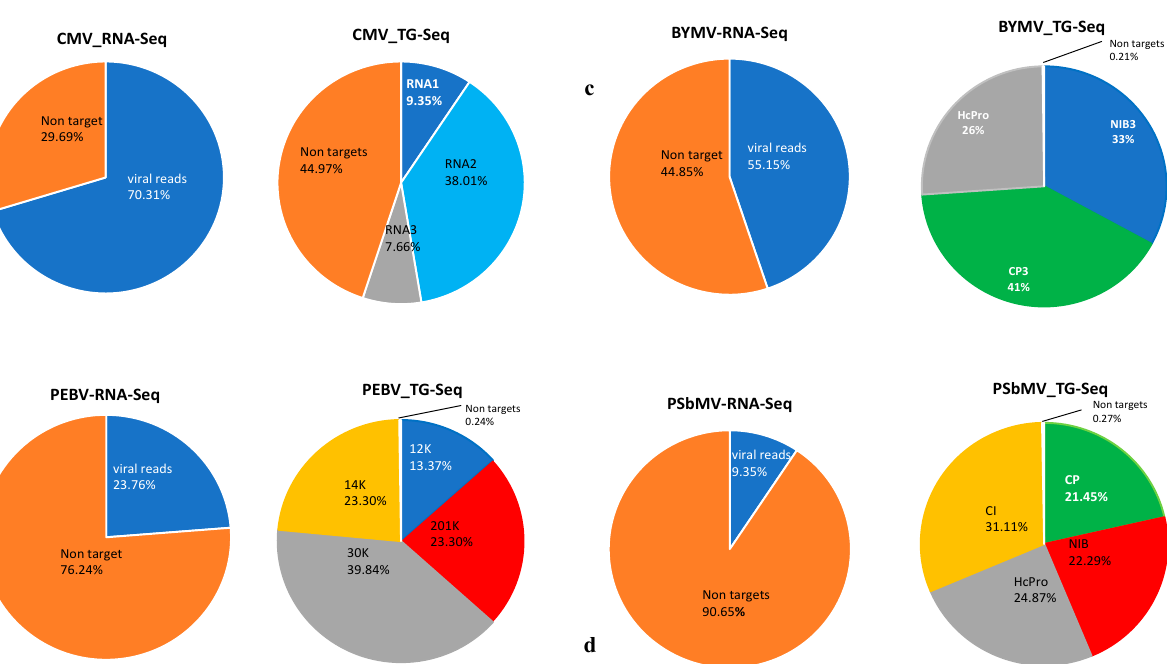
A 100-fold serial dilution (10 − 2 , 10 − 4 , 10 − 6 , 10 − 8 ) of viral cDNA in nuclease free water from each of the four viruses was used as template. Amplicons detected by TG-Seq, CMV (RNA1), PEBV (201K), PSbMV (CP), BYMV (HcPro). Amplicons detected by gel visualisation at serial dilution 10 − 2 * (201K, RNA1, HcPro) 10 − 4 (RNA1, HcPro), 10 − 6 (RNA1, HcPro *), 10 − 8 (RNA1, HcPro *) = (nearly invisible), () = figures in parenthesis are the number of reads mapping to each genome region of interest.